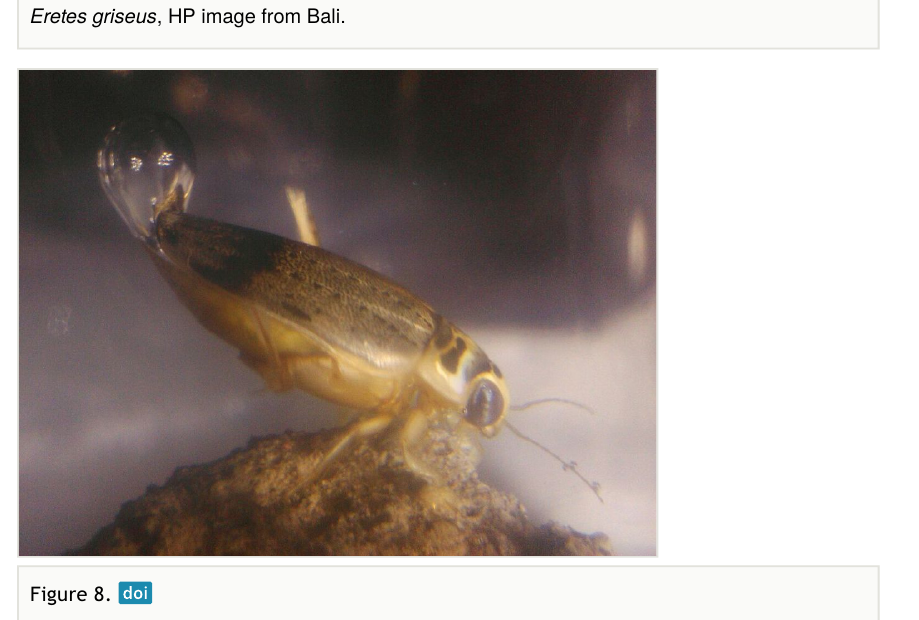
Hydaticus bipunctatus conjungens (Figs 3, 5). Hydaticus fabricii (Fig. 3).